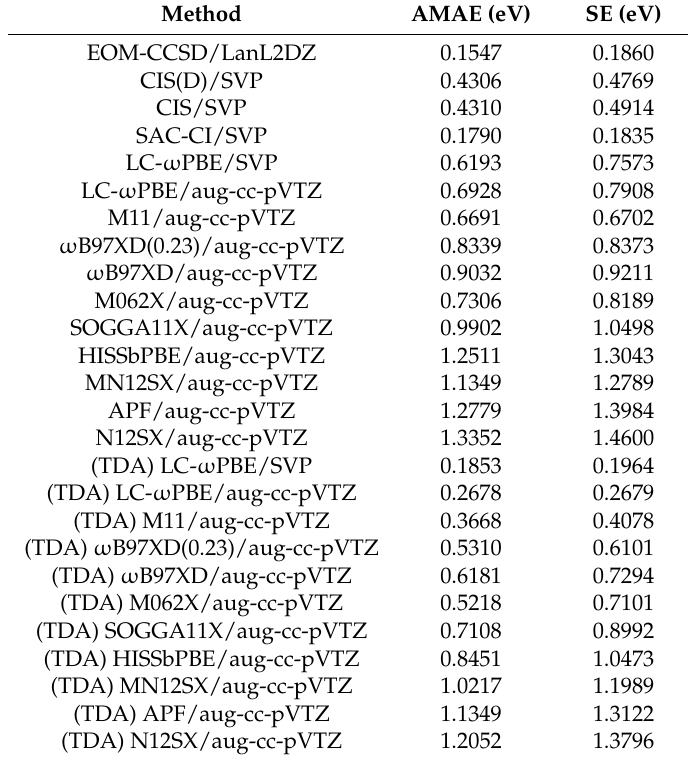
Table 4. According to the EOM-CCSD/SVP benchmark results, the listed data are the calculated arithmetic mean of the absolute errors (AMAE) and standard errors (SE) of the vertical electronic excitation energies for the B-TCNE